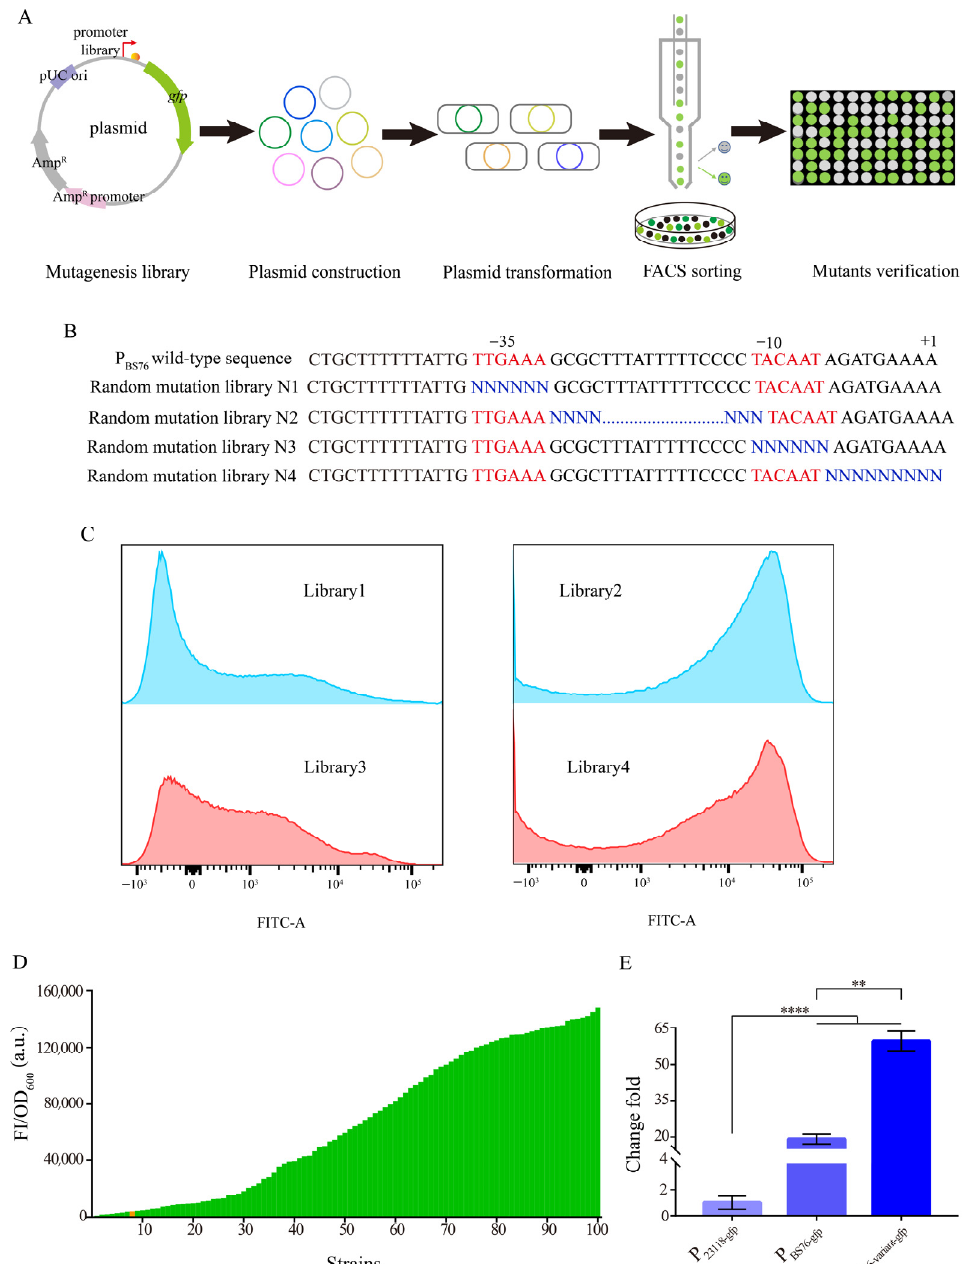
Figure 3. Construction of a gradient promoter library based on the promoter random mutation library. ( A ) Workflow of construction and screening of the promoter random mutation library. ( B ) Specific mutation patterns of the four mutation libraries. The degenerate bases introduced during PCR primer synthesis are highlighted in blue color. The –35 and –10 regions of promoter P BS76 are highlighted in red color. The other sequences of promoter P BS76 are showed in black color. ( C ) Range of fluorescence intensity of the four constructed libraries. ( D ) Fluorescence intensity of the random selected mutants for the second round of screening. The orange band represents the fluorescence intensity of P BBa_J23118 - gfp . ( E ) Comparison of fluorescence intensity among P 23118 - gfp , P BS76 - gfp , and P BS76-variant - gfp . P 23118-gfp indicates P BBa_J23118-gfp . For E, error bars indicate standard deviations. One-way analysis of variance (ANOVA) was used to examine the mean differences between the data groups. **** p < 0.001, ** p < 0.01.